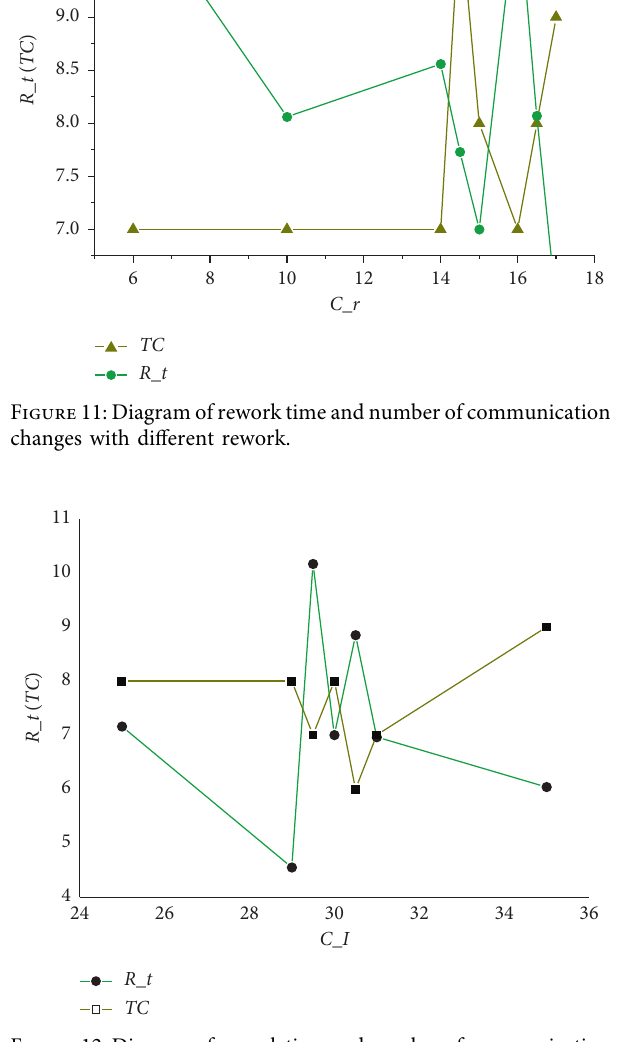
Figure 12: Diagram of rework time and number of communication changes with different overlapping costs.